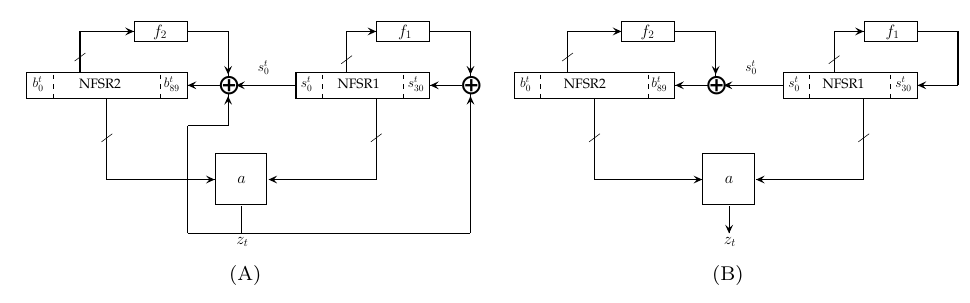
Figure 1: Block Diagram of Lizard (A) In Phase 2 of Initialization, (B) During keystream